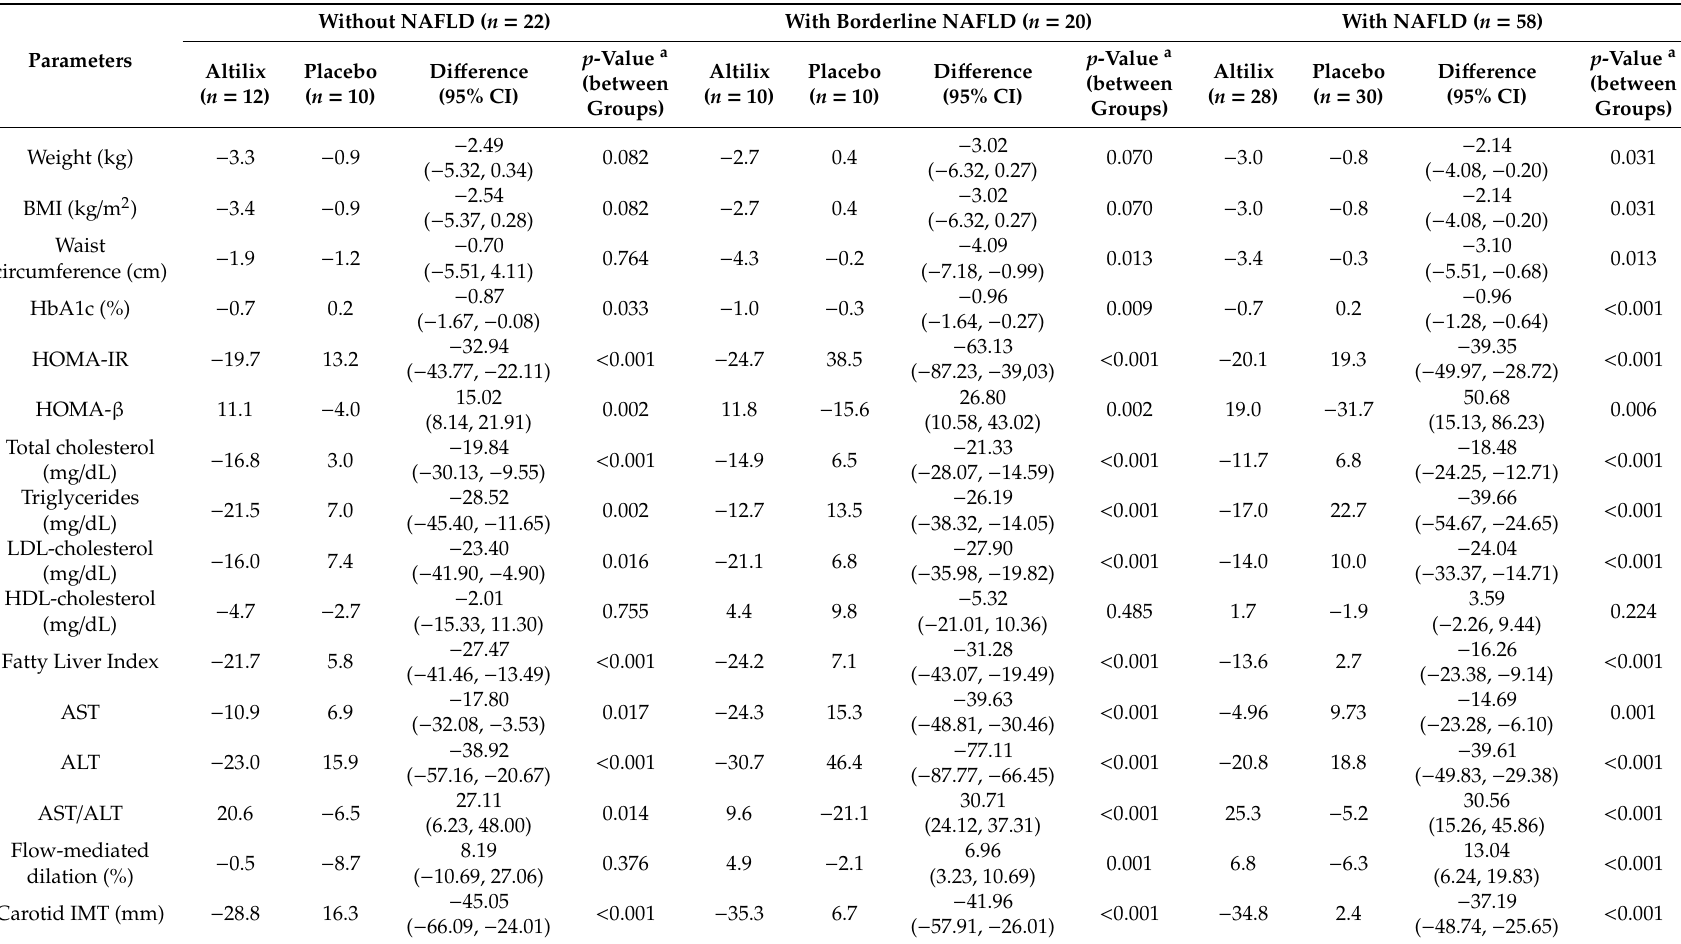
Table 3. Cardiometabolic parameters at baseline and at the end of the study, in relation to the presence and degree of non-alcoholic fatty liver disease (NAFLD) ( n =